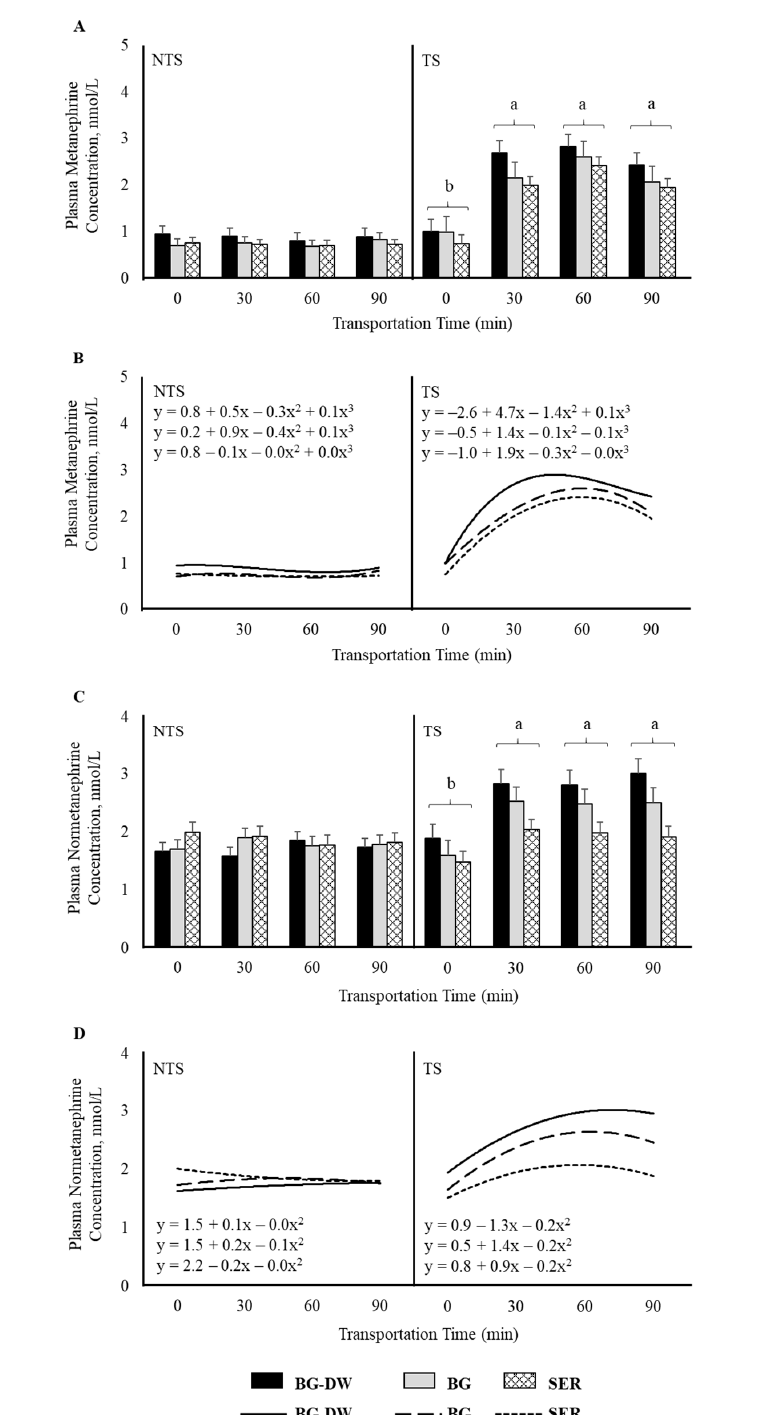
Figure 4. Effects of Diet (BG-DW: bermudagrass hay—dewormed; BG: bermudagrass hay; SER: sericea hay), Stress Treatment (ST; NTS: non-transported; TS: transported), and Time on plasma ( A ) metanephrine (ST, p < 0.01; Time, p < 0.01; ST × Time, p < 0.01) concentrations in goats. ( B ) Polynomial contrasts showing a significant cubic trend ( p < 0.01) over Time. ( C ) Normetanephrine (ST, p < 0.01; Time, p < 0.01; ST × Time, p < 0.01; Diet × ST, p < 0.01) concentrations in goats. ( D ) Polynomial contrasts showing a significant quadratic trend ( p < 0.01) over Time. Bars represent means with